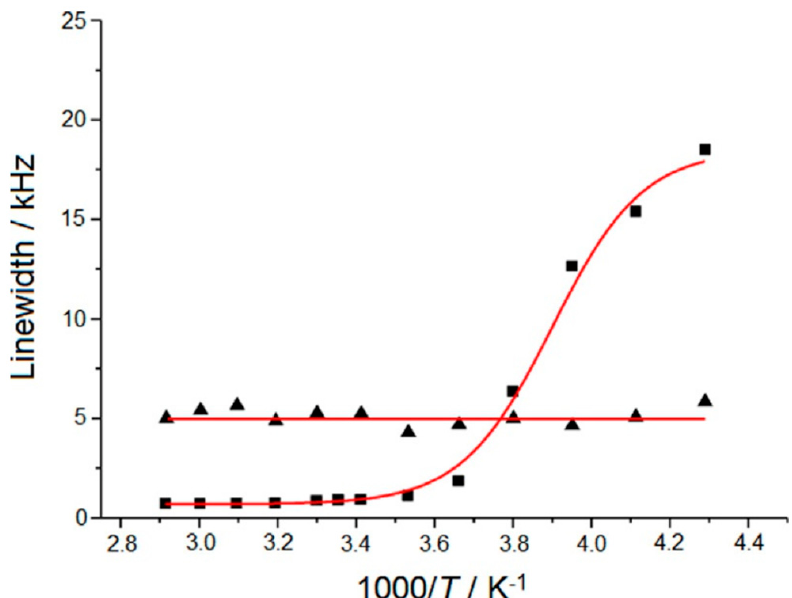
Figure 2. Comparison of 19 F NMR linewidths for (triangle) Al 2 O 3 -PEG9-anion (5 nm). [EO]/[Li]~50 in PEO/PEGDME~1, and (square) LiTFSI in PEO [EO]/[Li]~20 as a function of temperature [23] © 2015 Wiley-VCH Verlag GmbH & Co. KGaA, Weinheim.